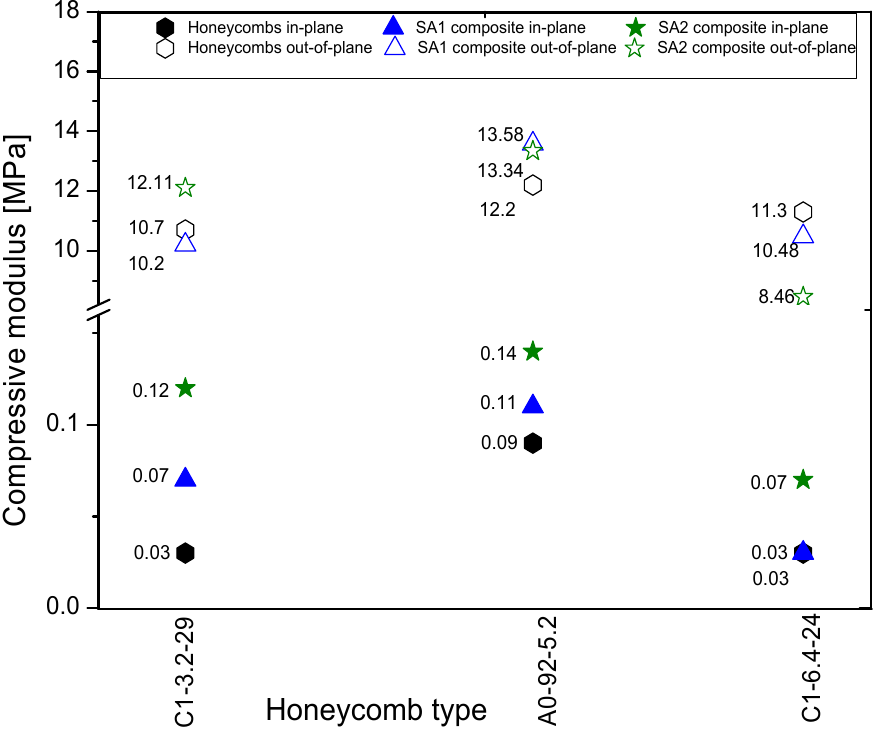
Figure 18. Compressive moduli of empty and field honeycombs in two directions. Since we could observe defects in the manufactured materials (air bubbles, holes), these weak points should be prevented. Research along this line is currently in progress.